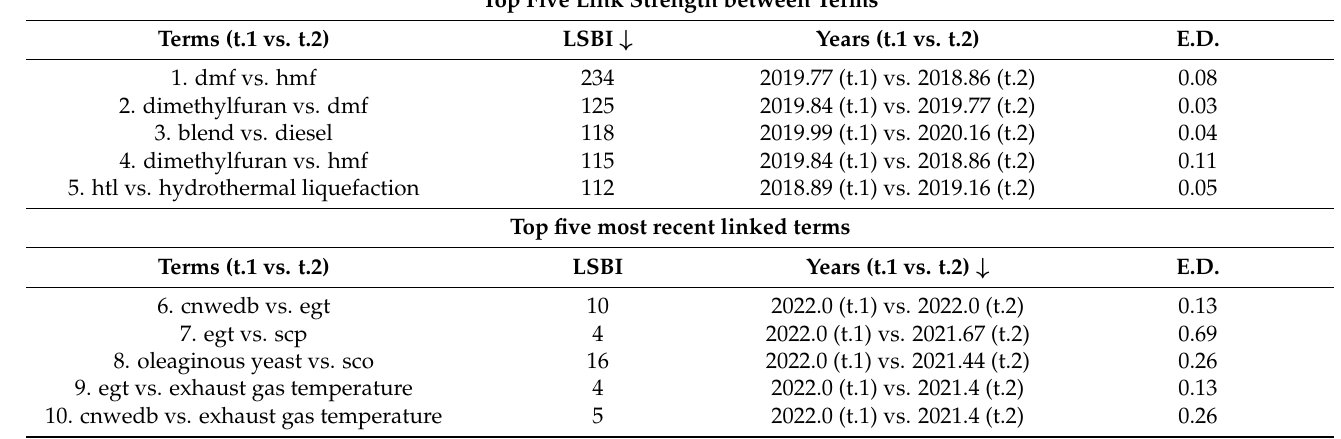
Table 1. Main information from software containing the top five LSBI and top five most recent linked